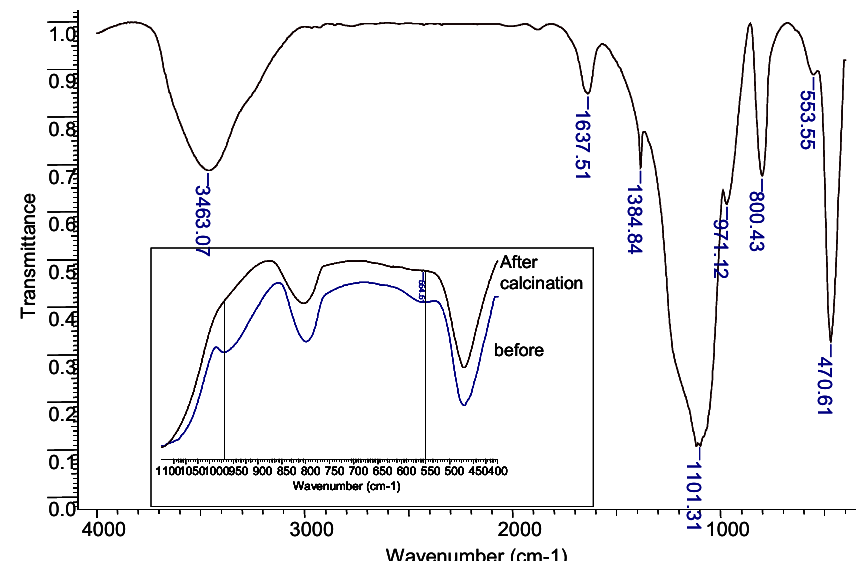
Figure 1. FTIR spectrum of the SilAg precursor before calcination; insert-region of interest before and after calcination.